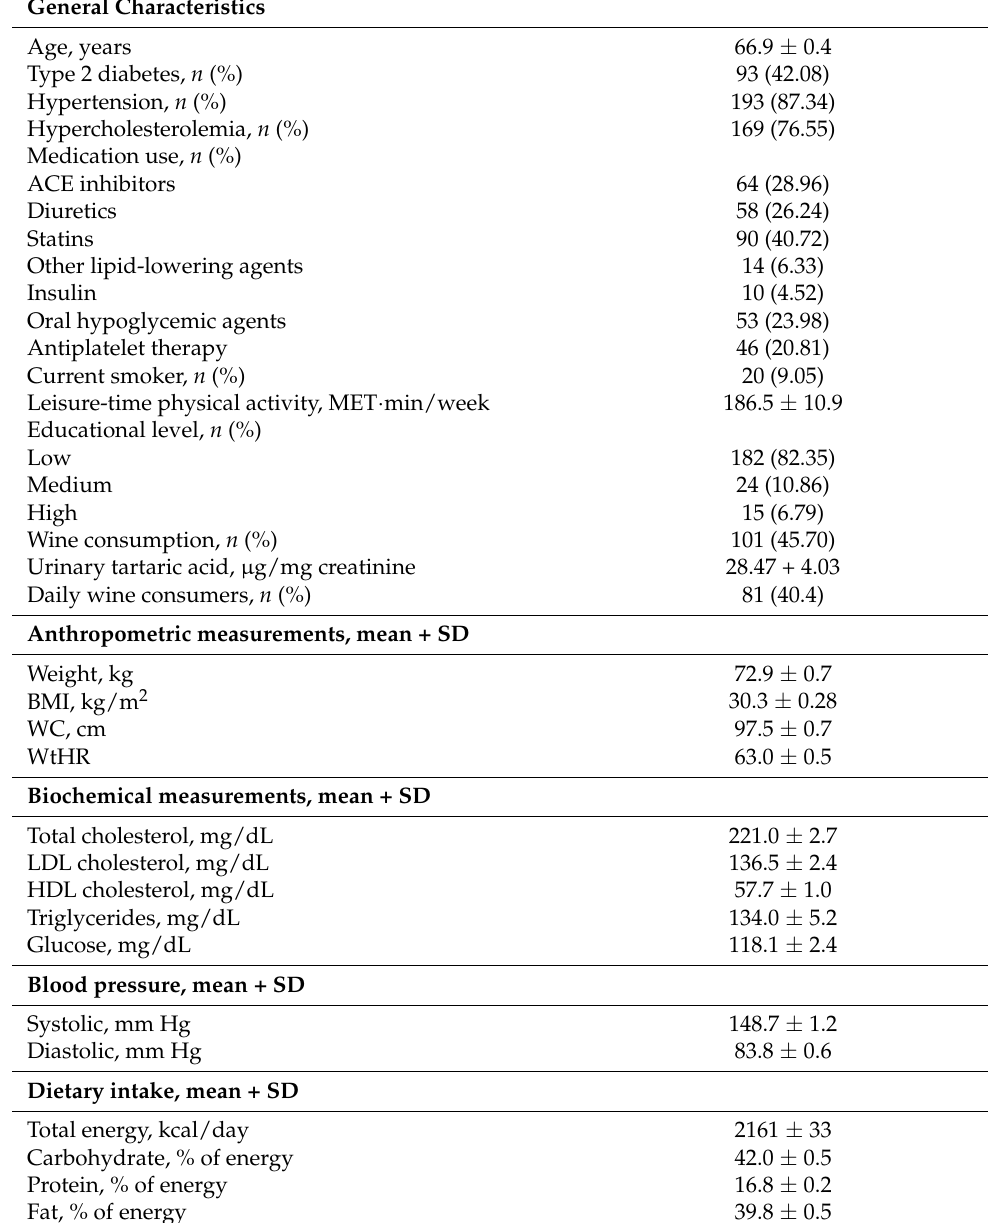
Table 1. Baseline characteristics of the women in the study population ( n =